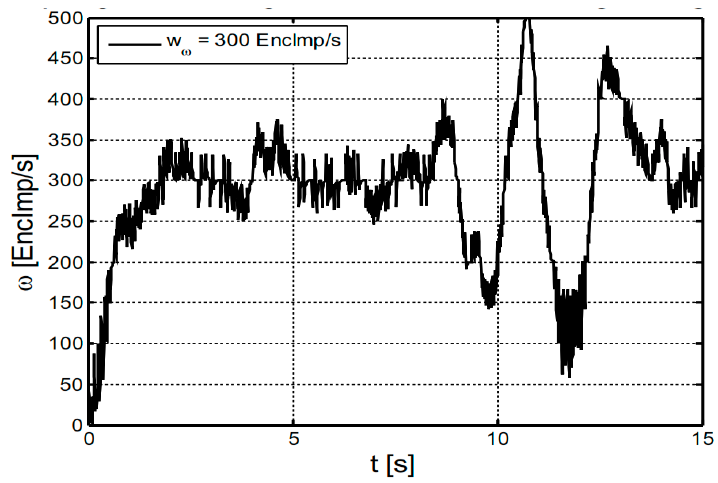
Figure 10. Step response of closed speed controller with disturbance.